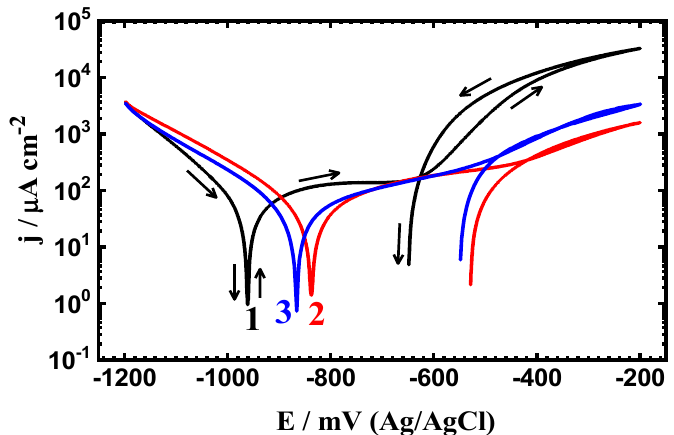
Figure 5. Cyclic potentiodynamic polarization (CPP) measurements obtained for (1) PS, (2) PSC1, and (3) PSC2 in 4% NaCl solution after 1.0 h of exposure.